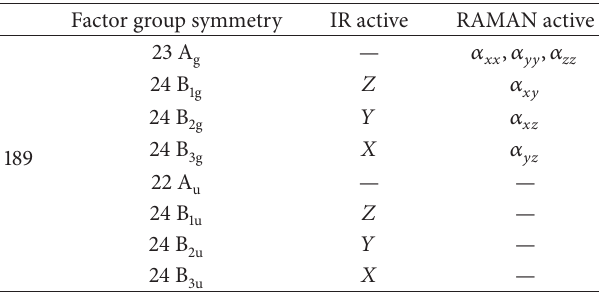
Table 4: Correlation